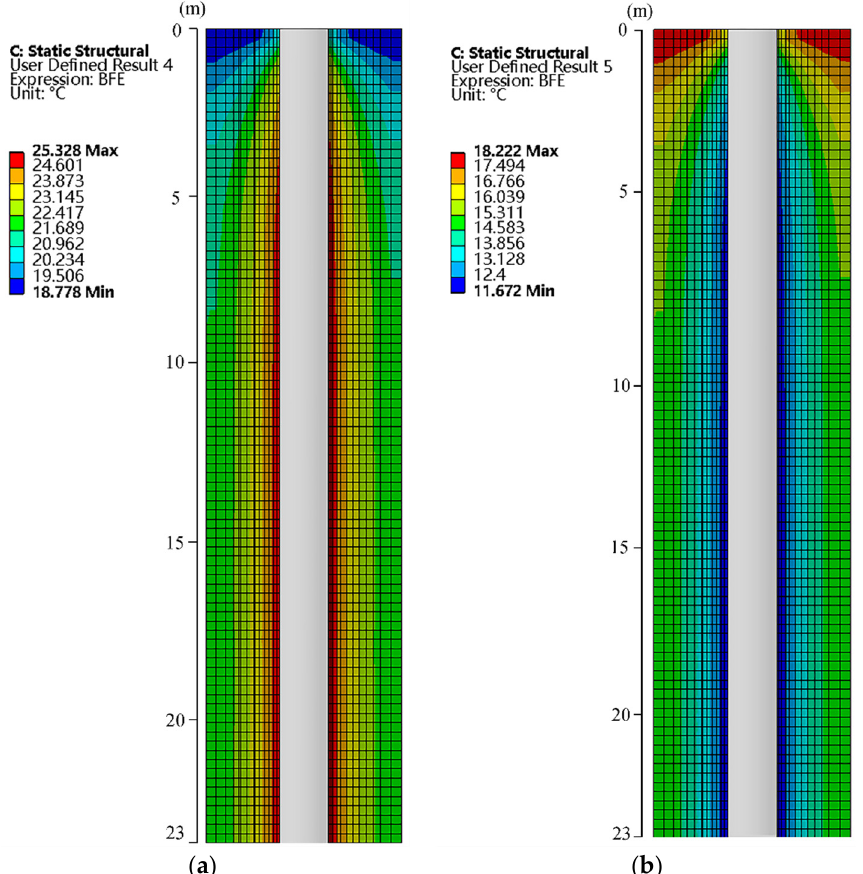
Figure 6. The temperature distribution of the longitudinal section of the pile: ( a ) heating condition; ( b ) cooling condition.